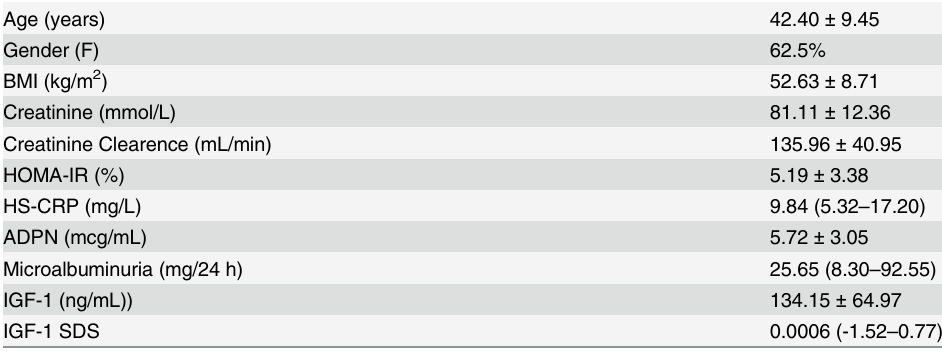
Table 1. Anthropometric and biochemical